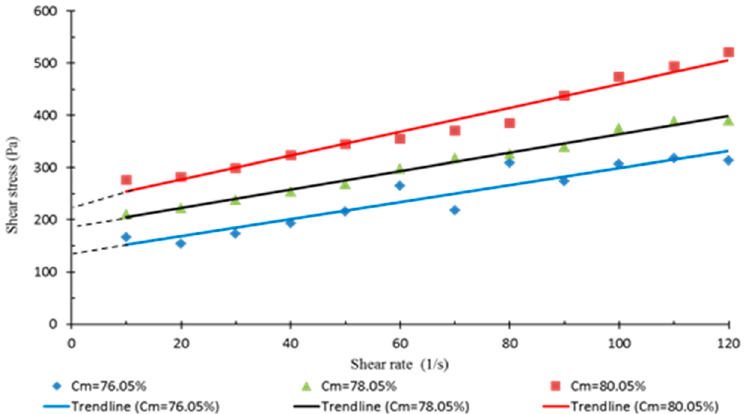
Figure 3. This relation of the shear stress to shear rate on the various solid concentration among 76.05%, 78.05% and 80.05%.